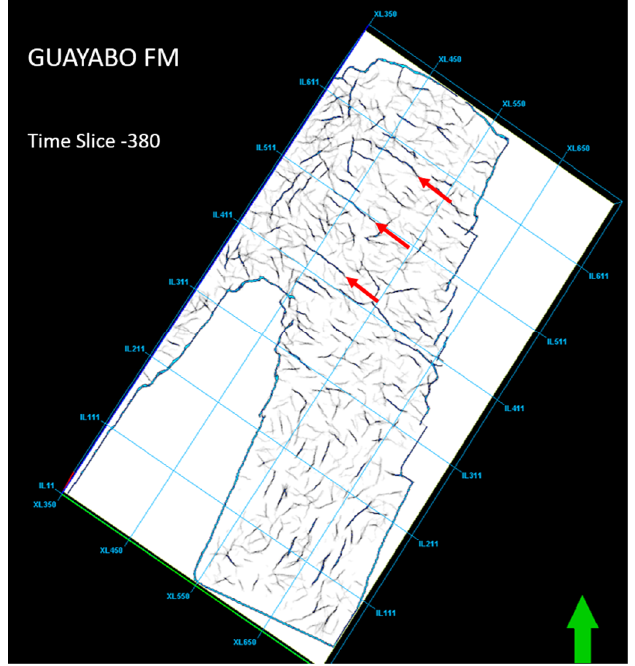
Figure 15. Time slice at 380 msec showing the WNW–ESE fracture direction in the Guayabo Fm in the footwall block.